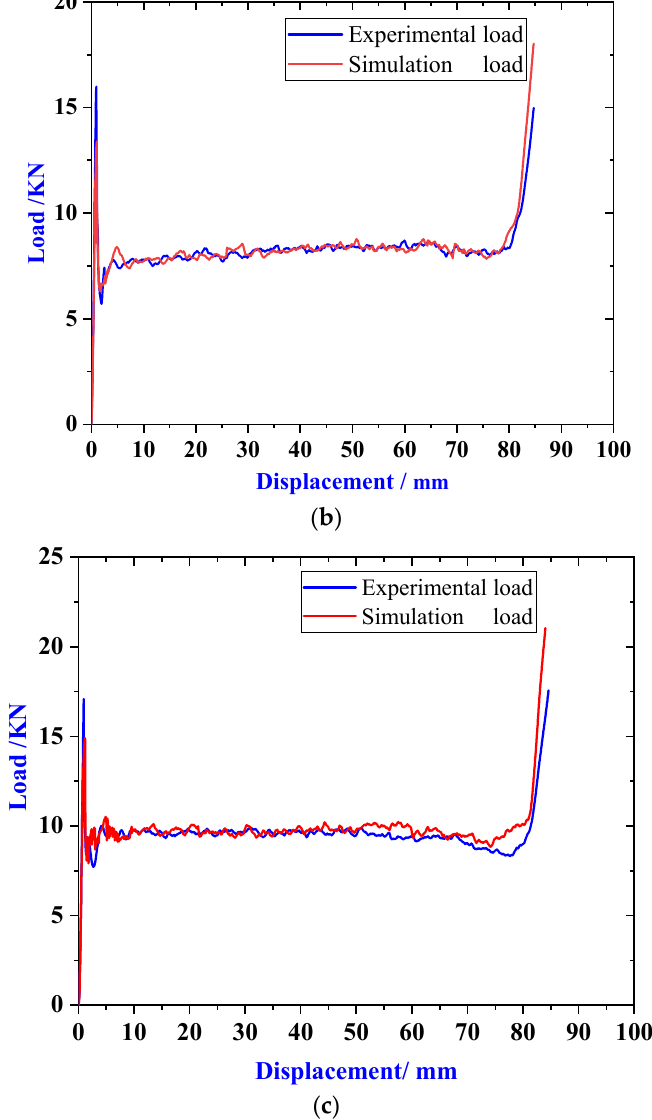
Figure 7. Load–displacement curve of ( a ) HB1, ( b ) HB2, and ( c ) HB3. Figure 7. Load-displacement curve of ( a ) HB1, ( b ) HB2, and ( c )